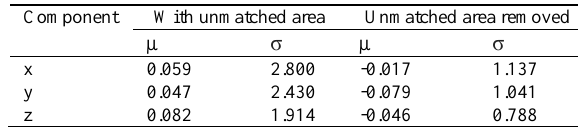
Table 4. Mean distance (µ) and standard deviation (σ) of point to point distance calculation of two